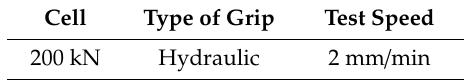
Figure 3. ( a ) The placement of the welded specimen between the grips of the tensile test, ( b ) the grips used for holding samples (a SOLIDWorks ® design). used for holding samples (a SOLIDWorks ® design). Table 5. Tensile tests parameters according to ASTM A Table 5. Tensile tests parameters according to ASTM A 370.